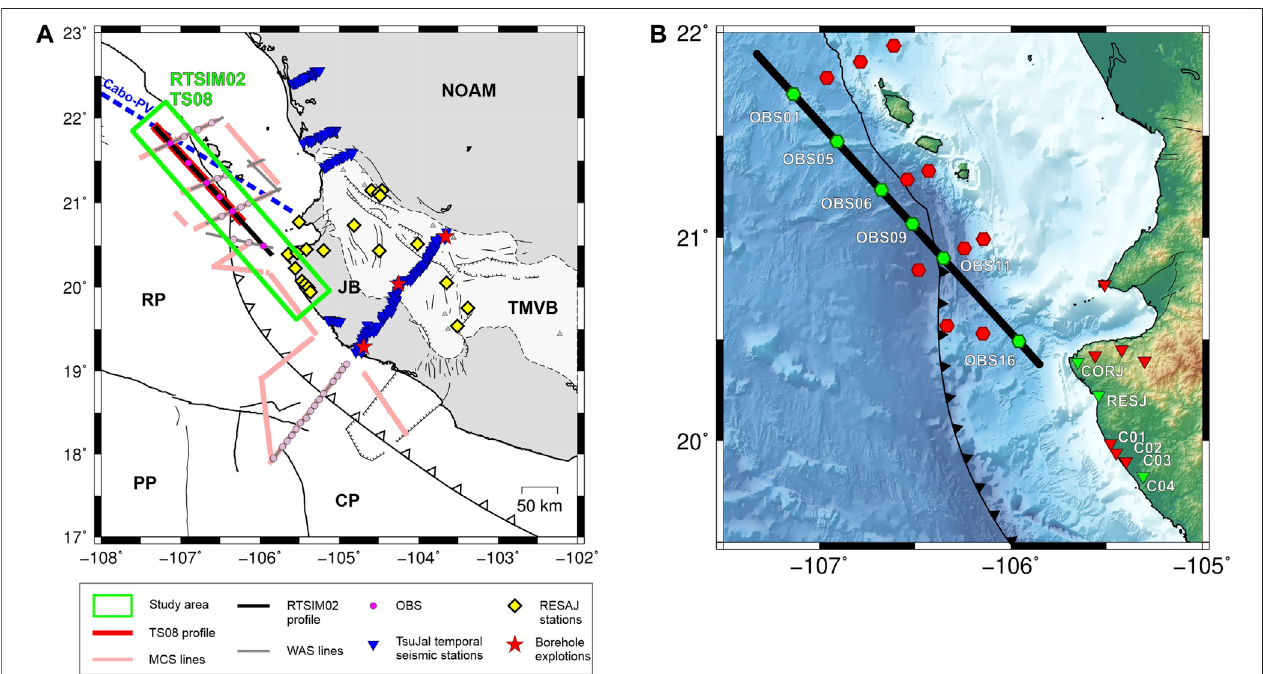
FIGURE2|(A) TsuJalexperimentdeploymentmap.SymbolsaredepictedinthelegendbelowthePanel,andabbreviationsarethesameasin Figure1 .Dashblue line denotes Cabo-Puerto Vallarta segment studied by Lizarralde et al. (2007). Abbreviations: CP, Cocos plate; JB, Jalisco block; MCS, Multichannel Seismic; NOAM, North American plate; OBS, Ocean-bottom seismometer; PP, Paci fi c plate; RESAJ, Jalisco Seismic Accelerometric Telemetric Network stations; RP, Rivera plate; TMVB, Trans-Mexican volcanic belt; WAS, wide-angle seismic. (B) Deployment map in the study area with seismic stations used to generate the P-wave velocity model of RTSIM02 seismic transect (green symbols). Red polygons denote the seismic stations deployed but not used in this study.